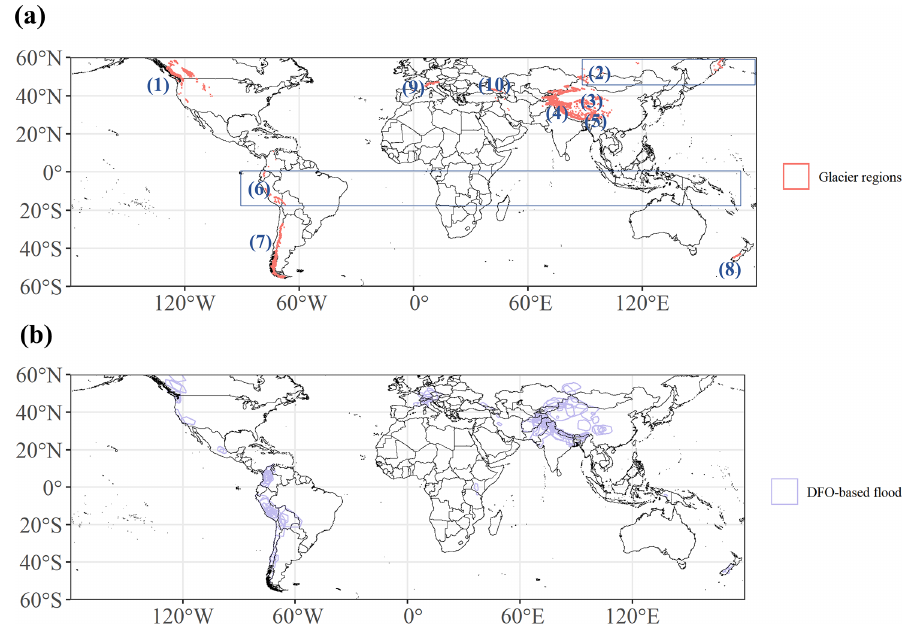
Figure 5. Global glacier distribution (a) and corresponding DFO-based flood events (b) for (1) glacial regions in western Canada and the US, (2) glacial regions in North Asia, (3) glacial regions in Central Asia, (4) glacial regions in the western South Asia, (5) glacial regions in the eastern South Asia, (6) glacial regions at low latitudes, (7) glacial regions in the southern Andes, (8) glacial regions in New Zealand, (9) glacial regions in central Europe and (10) glacial regions in central eastern